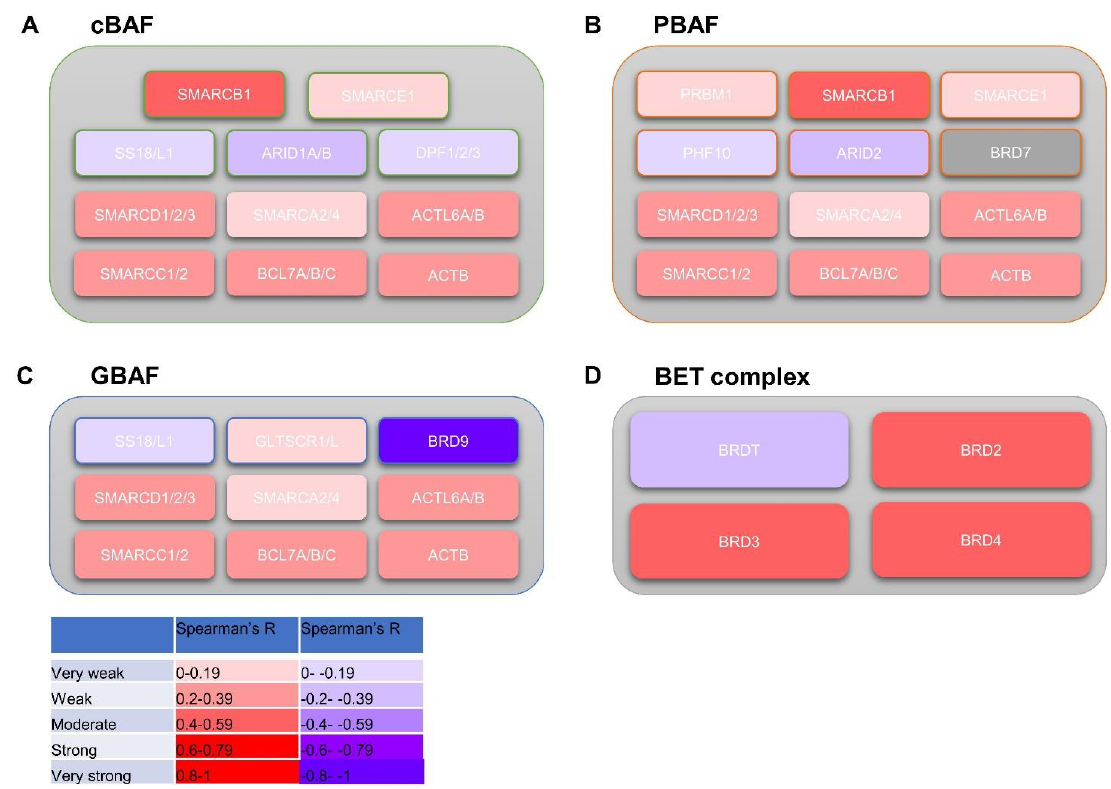
Figure 4. An overview of BRD9 correlation with genes composing the SWI/SNF and BET complexes. Heatmap diagrams showing mean significant Spearman’s R BRD9 correlation from datasets with gene subunits composing SWI/SNF subcomplexes (cBAF, PBAF, GBAF) and BET complex. ( A ) Heatmap diagram showing mean significant Spearman’s R BRD9 correlation from datasets with gene subunits composing the cBAF subcomplex. ( B ) Heatmap diagram showing mean significant Spearman’s R BRD9 correlation from datasets with gene subunits composing the PBAF subcomplex. ( C ) Heatmap diagram showing mean significant Spearman’s R BRD9 correlation from datasets with gene subunits composing the GBAF subcomplex. SWI/SNF diagrams adapted from Centore et al’s Figure 1 [15]. Image created using Microsoft PowerPoint. ( D ) Heatmap diagram showing mean significant Spearman’s R BRD9 correlation from datasets with gene subunits composing the BET complex.